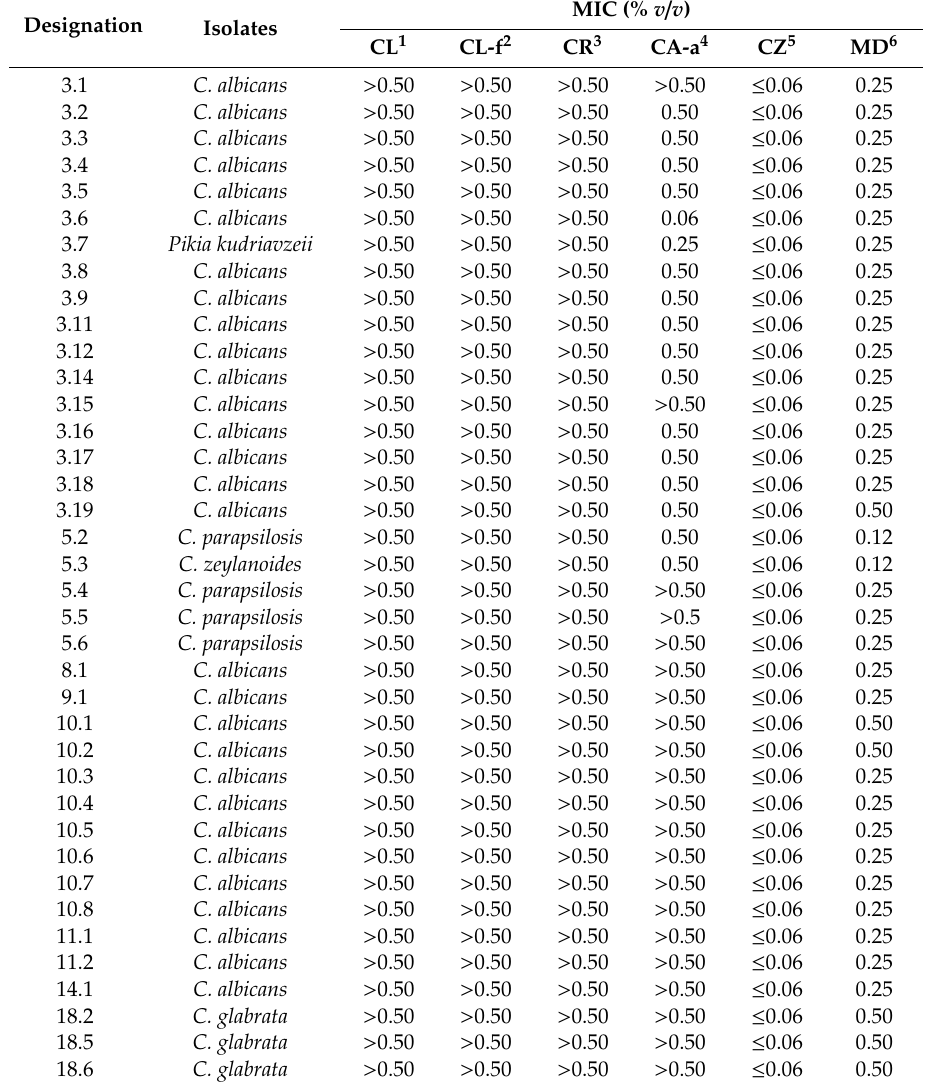
Table 1. MIC values of selected clinical Candida spp. isolates against the essential oils in